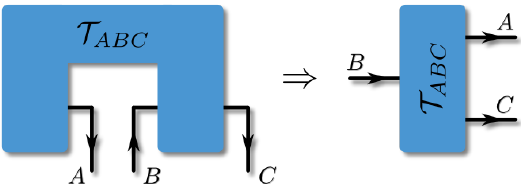
Figure 8: Comb as a broadcasting channel. Due to its properties, any